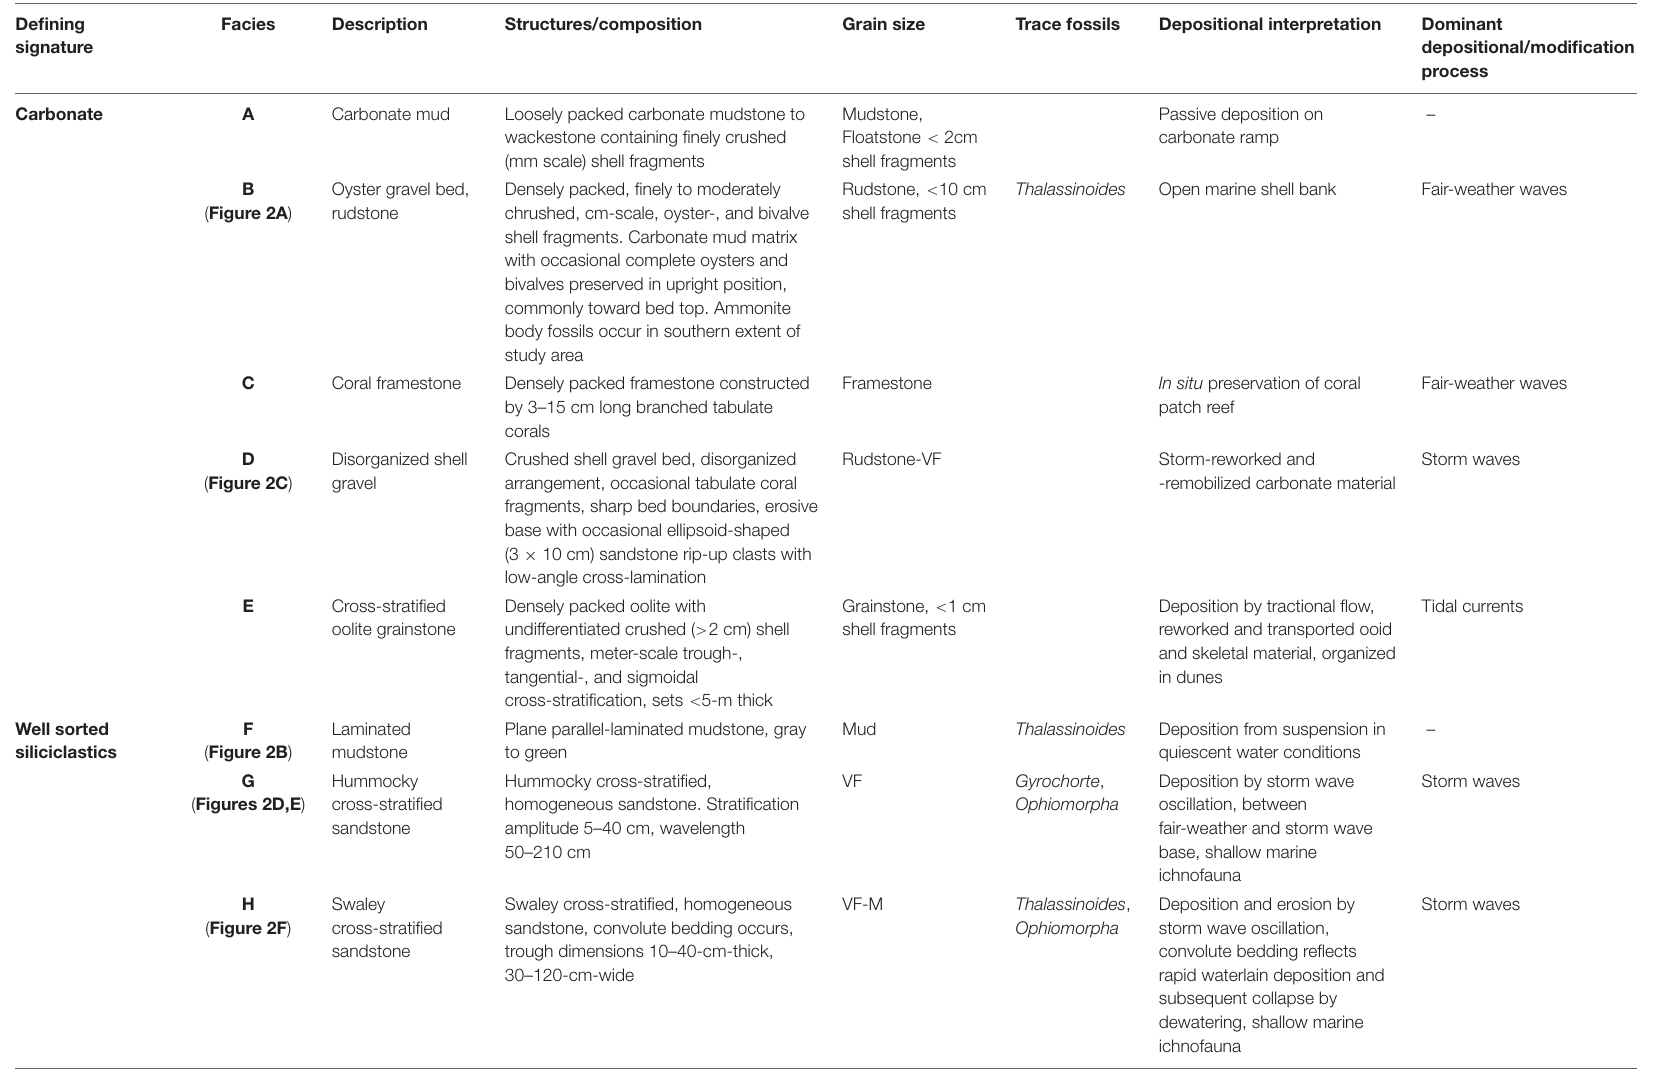
TABLE 1 | Recorded sedimentary facies in the middle and upper Mulichinco Fm., facies are grouped according to their defining signature, and subordinately arranged in ascending stratigraphic